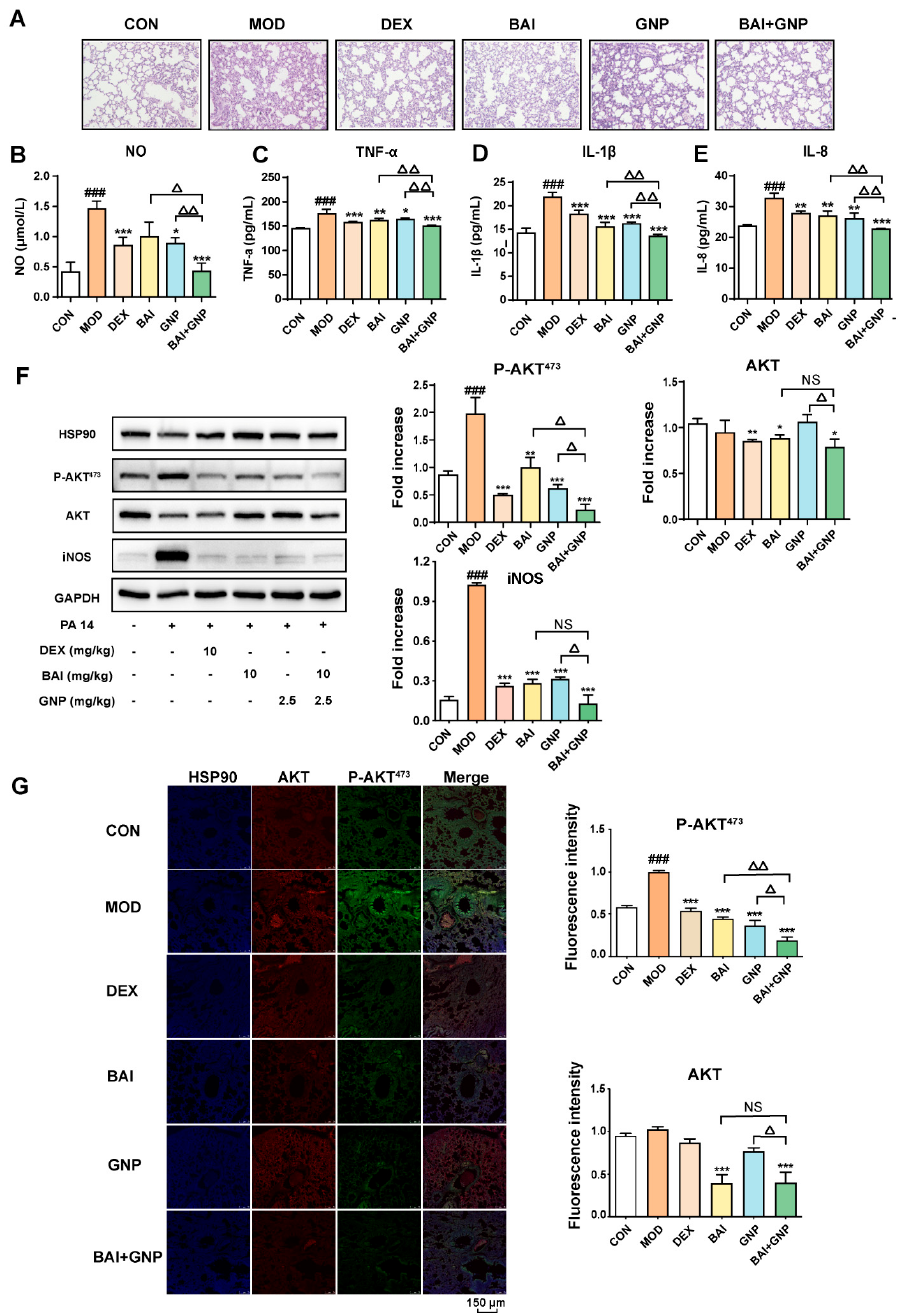
Figure 5. Synergistic effects of BAI and GNP on acute lung injury induced by the PA 14 bacterial strain in mice. ( A ) Representative images of hematoxylin and eosin staining of lung tissues (400 × ). ( B – E ) BAI and GNP synergistically inhibited the production of nitric oxide, TNF- α , IL-1 β , and IL-8, respectively, induced by lipopolysaccharide in bronchoalveolar lavage fluid of mice ( n = 6). ( F ) The combination of BAI and GNP attenuated the expression on P-AKT 473 , AKT, and iNOS ( n = 3). ( G ) BAI and GNP synergistically decreased the protein levels of AKT and P-AKT 473 in lung tissue ( n = 3). Each bar represents the mean ± SD. ### p < 0.001 vs. control group; * p < 0.05, ** p < 0.01, and *** p < 0.001 vs. model group; (cid:52) p < 0.05 and (cid:52)(cid:52) p < 0.01 vs. combination group. BAI, baicalein; CON, control; DEX, dexamethasone; GNP, genipin; HSP90, heat shock protein 90; IL-1 β , interleukin 1 β ; IL-8, interleukin 8; INOS, inducible nitric oxide synthase; MOD, model; NO, nitric oxide; PA 14, Pseudomonas aeruginosa 14 strain; TNF- α , tumor necrosis factor- α